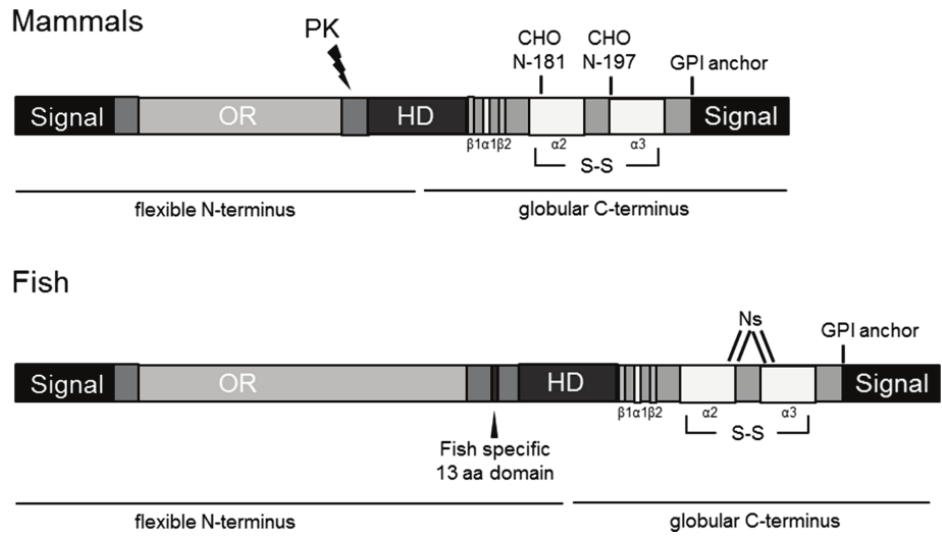
Figure 1. Conserved structural domains in piscine and mammalian prion proteins. Schematic illustration of prion proteins in mammals and fish. Signal, signal peptides; OR, octarepeat region; HD, hydrophobic domain; CHO N -, N -glycosylation sites; – S – S – , disulphide bond; β1, β2, β - sheets; α1, α2, α3, GPI anchor, glycosylphosphatidylinositol anchor; PK, proteinase K cleavage